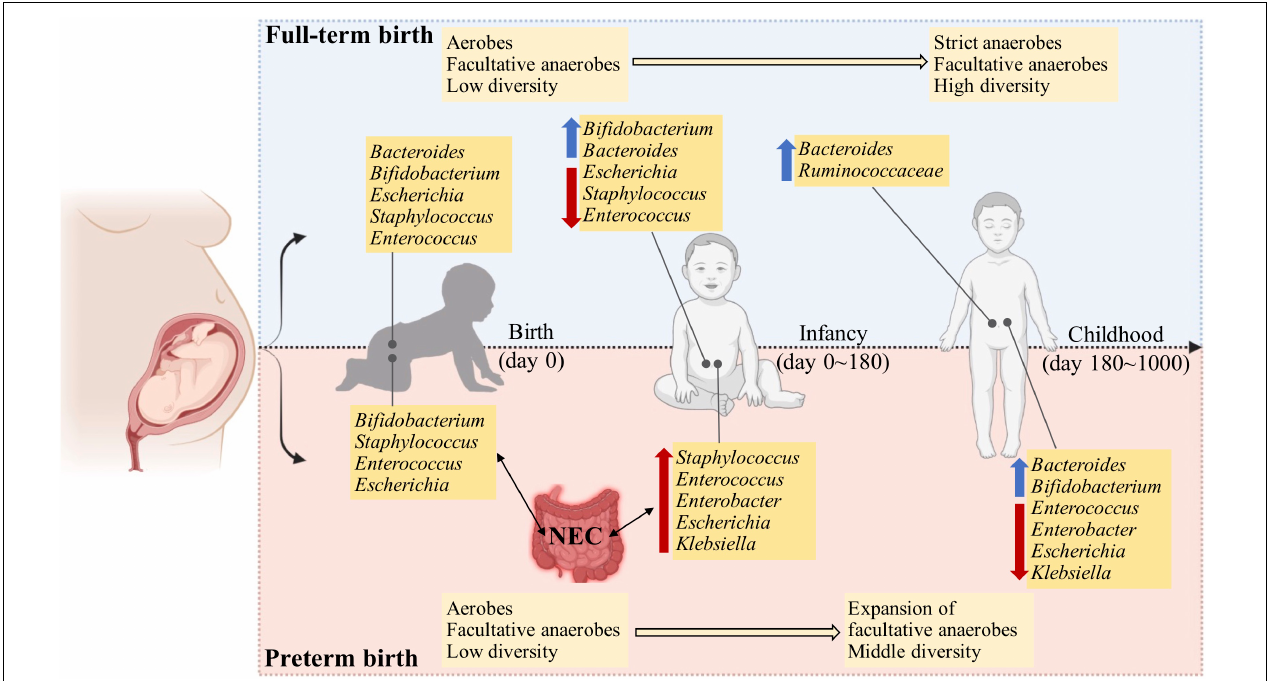
FIGURE 1 | The developmental trajectory and comparisons of full-term and preterm infants in the first 1000 days after birth. Compared to full-term infants, the preterm infants show a dysbiosis of gut microbiota, typically with higher abundance and longer persistence of facultative anaerobes and opportunistic pathogens in early life. This may be attributed to the physiological immaturity and an increase in the oxygen level in the gut lumen, which inhibits the proliferation and colonization of strict anaerobic